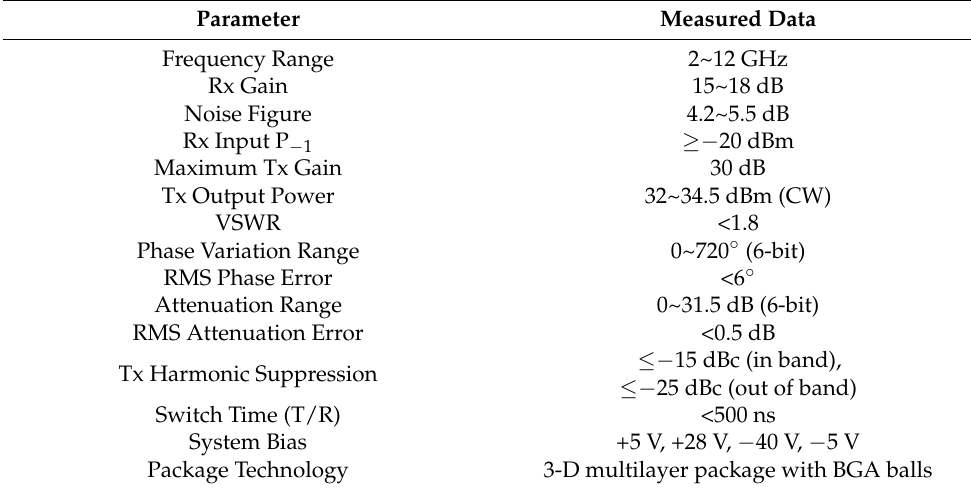
Table 1. Key electrical parameters of the